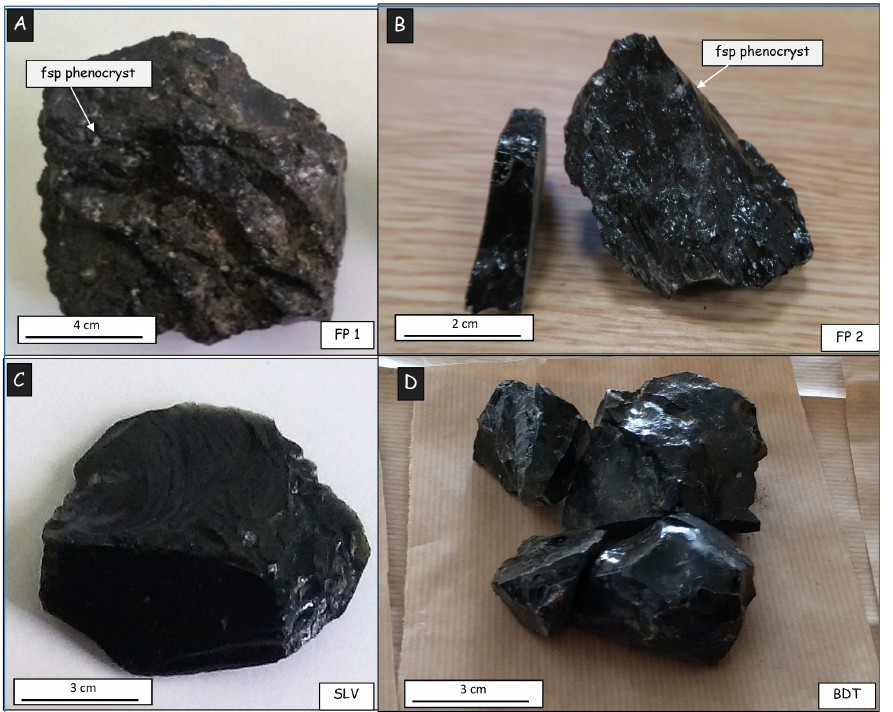
Figure 5: Hand-specimen photographs of representative obsidian samples: ( A ) Fossa Pernice 1; ( B ) Fossa Pernice 2 (note the feldspar